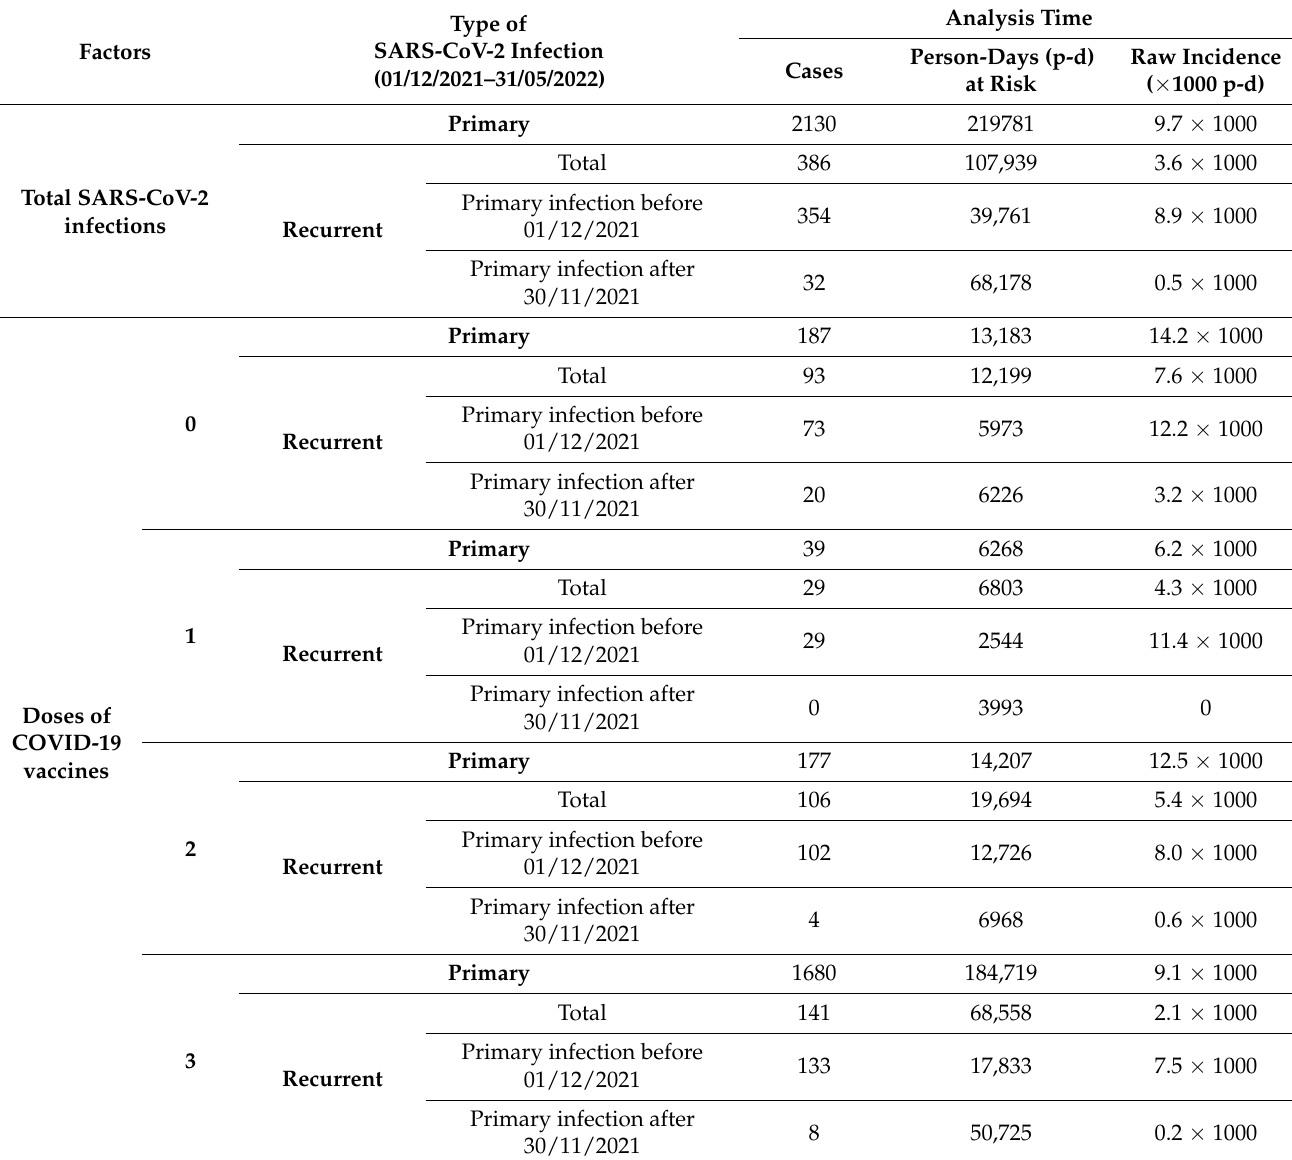
Table 3. Crude incidence rates of primary and recurrent SARS-CoV-2 infections during 1 December 2021-31 May 2022, by number of doses of COVID-19 vaccine received 7+ days (14+ days in case of only one dose) before infection. Number of cases, person-days (p-d) at risk and raw incidence ( × 1000 p-d).